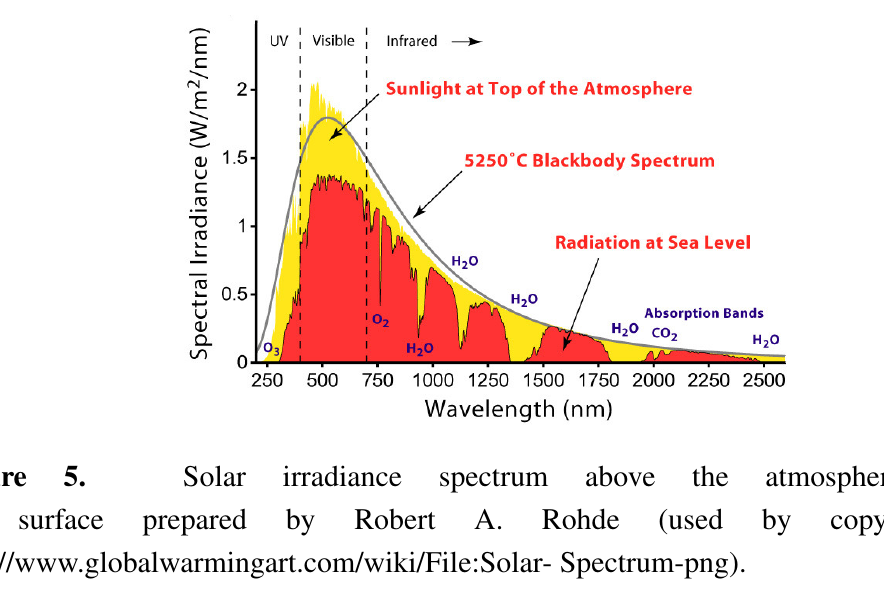
Figure 5. Solar irradiance spectrum above the atmosphere and at the surface prepared by Robert A. Rohde (used by copyright